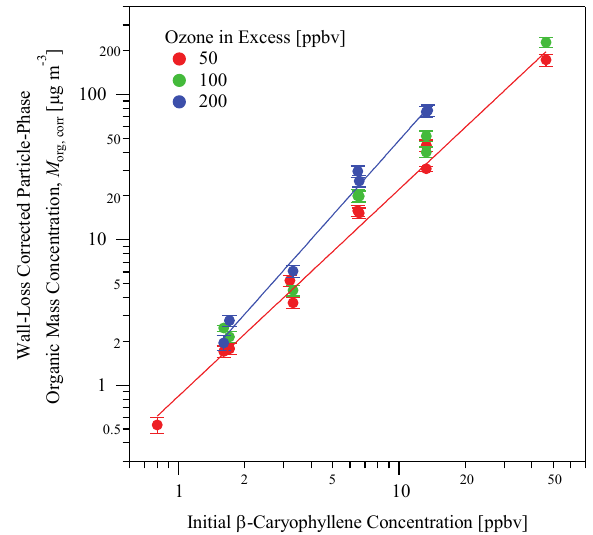
Fig. 3. Organic particle mass concentrations at steady state in the CMFR for increasing initial concentration of β -caryophyllene and three different ozone concentrations. The plotted concentrations are corrected for wall loss (Eq. 1). Uncertainties shown for the data points represent the propagated standard deviation (one sigma) of both the temporal variation of M org as well as the wall-loss correc- tions. Lines are shown to guide the